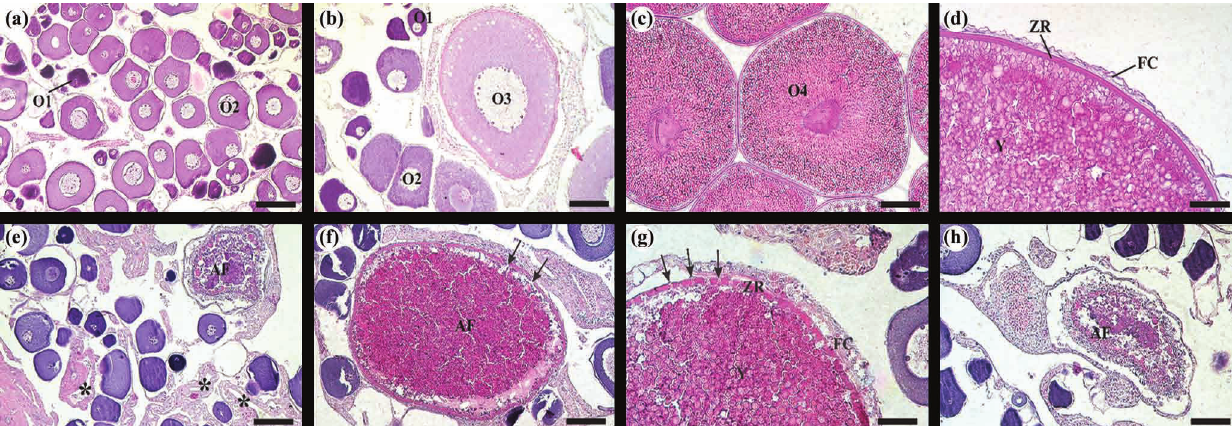
Fig. 2. Histological sections of Brycon orthotaenia ovaries stained with Hematoxilin-eosin: (a) resting stage presenting early (O1) and late (O2) perinucleolar follicles, (b)(c) maturing/mature stage presenting O1, O2, previtellogenic follicles (O3) and vitellogenic follicles (O4), (d) vitellogenic follicles containing yolk globules (Y), zona radiata (ZR) and follicular cells (FC), (e) spawned stage from site 2 with postovulatory follicles (asterisk) and rare vitellogenic atretic follicles (AF), (f)(g)(h) ovaries of B. orthotaenia collected in site 1 possessing several vitellogenic atretic follicles triggered by the cold water released by the Três Marias Dam, (f) vitellogenic follicle in early atresia with fragmented zona radiata (arrows), (g) hypertrophy of follicular cells, fragmented zona radiata (arrows) and yolk being degraded in atretic follicle and (h) vitellogenic follicle in advanced atresia. Bar = (a), (b), (h) 70 µm, (c) 160 µm, (d) 40 µm, (e) 100 µm, (f) 120 µm and (g) 50 µm.